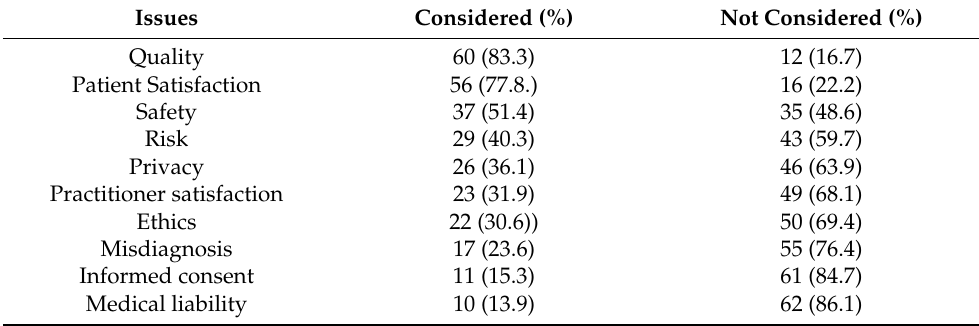
Table 2. Medicolegal and risk management problems among the 72 selected